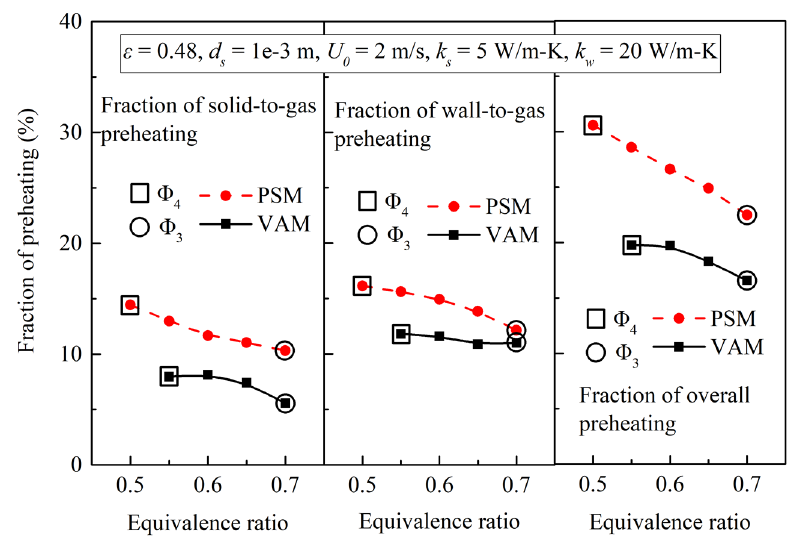
Figure 8. Fraction of preheating obtained by the PSM and VAM.